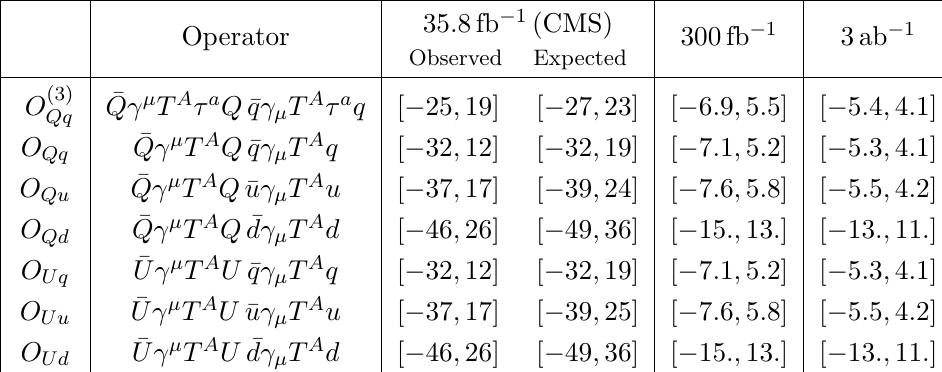
Table 1 . Gauge and Lorentz structure of dimension 6 four fermion operators leading to nonvanish- ing interference with the SM QCD q (cid:22) q ! t (cid:22) t amplitude at leading order and neglecting quark masses. We use capital letters Q and U to denote the third generation quark doublet and up-type singlet, while lowercase q; u , and d denote quarks from the (cid:12)rst two generations. SU(3) c and SU(2) EW generators are denoted by T A and (cid:28) a . In all the operators we sum over light quark (cid:13)avors. We re- port 95% CL bounds on c i , where the operators, O i , are normalized to have coe(cid:14)cients c i g 2 Current bounds are extracted from CMS data [43] (both observed and expected), while projections correspond to the higher luminosities of 300 and 3000 fb (cid:0) 1 at